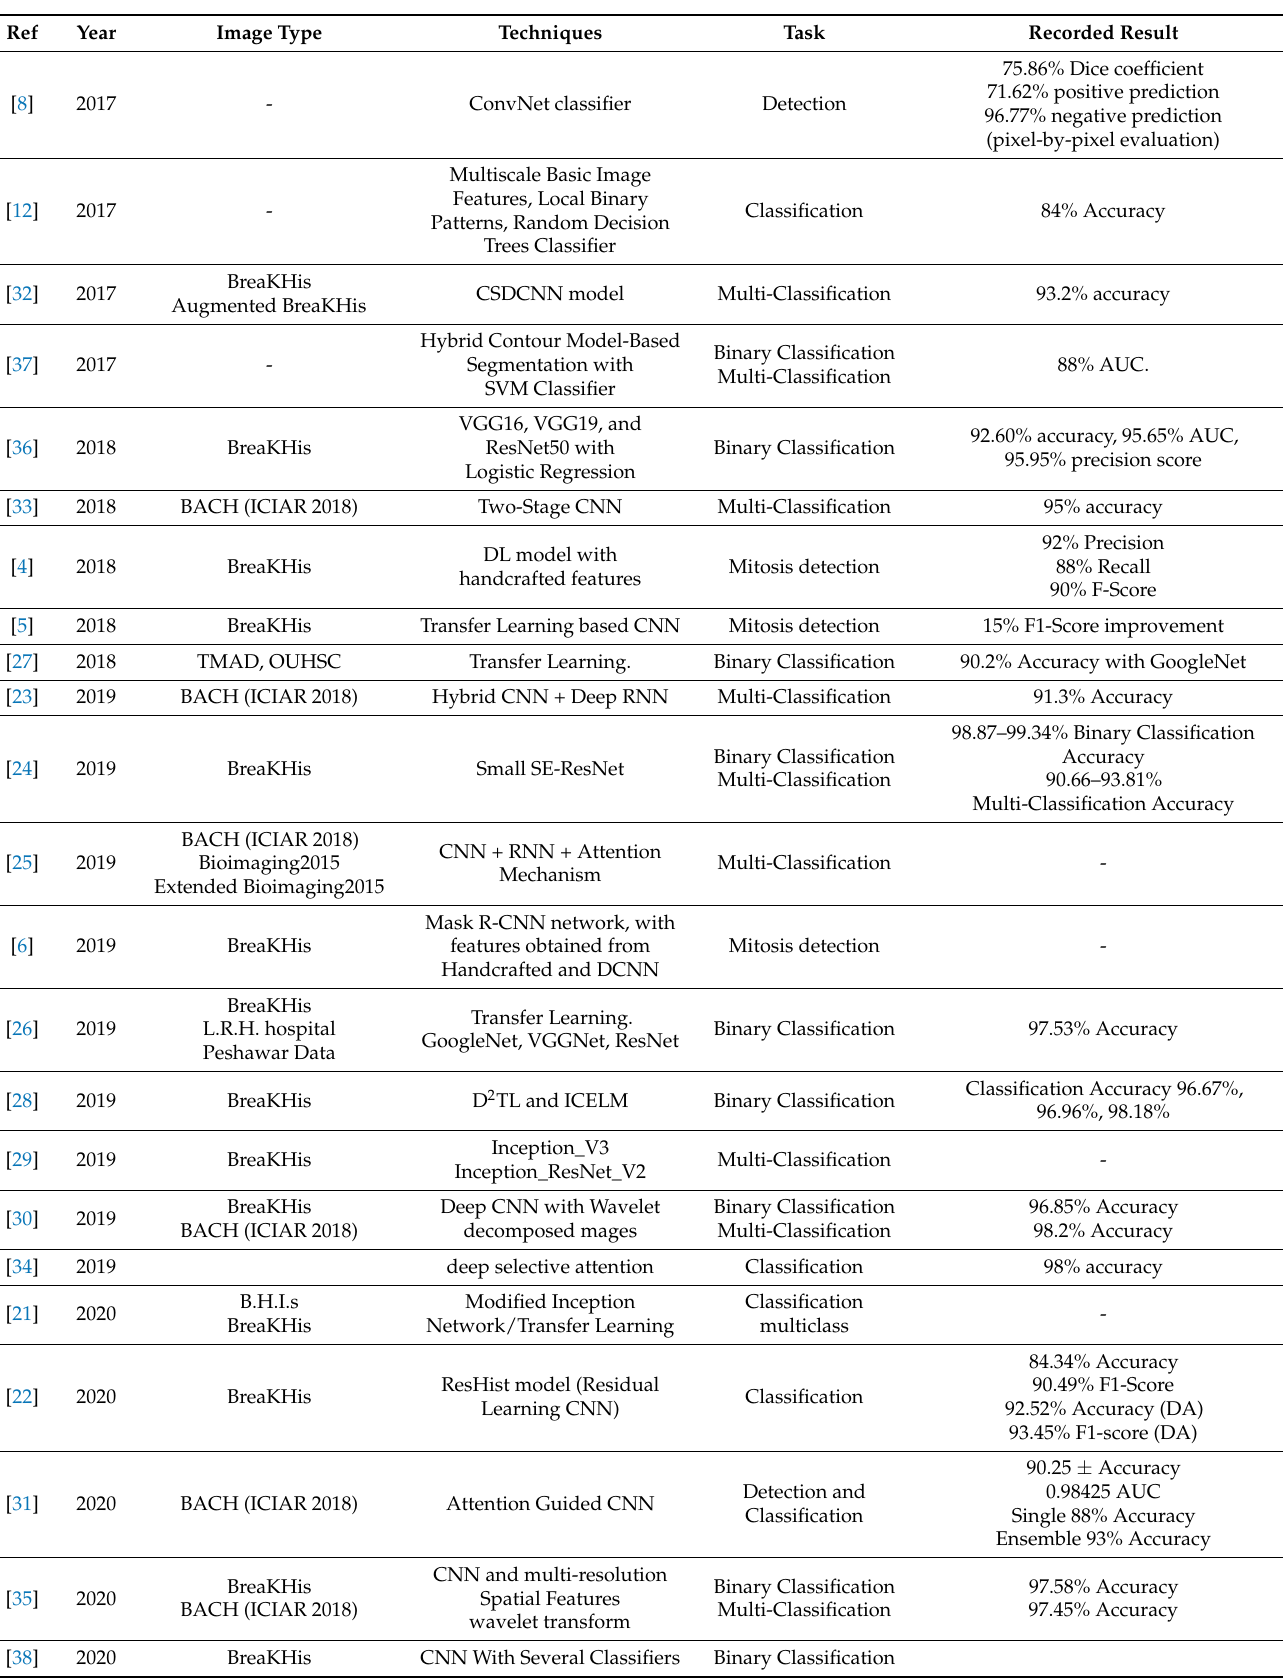
Table 2. Summary of the related